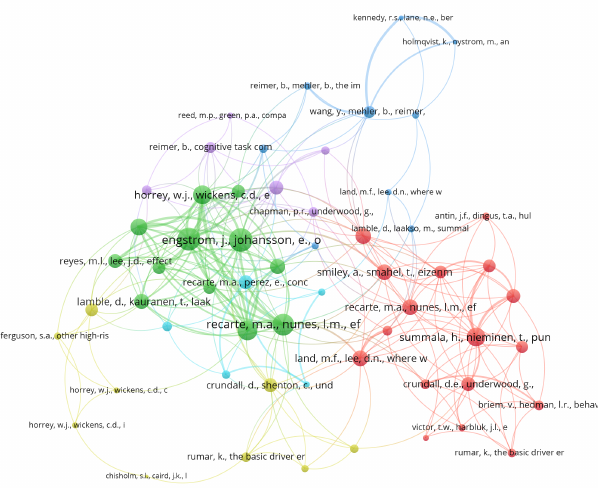
Figure 4. Co-citation analysis.